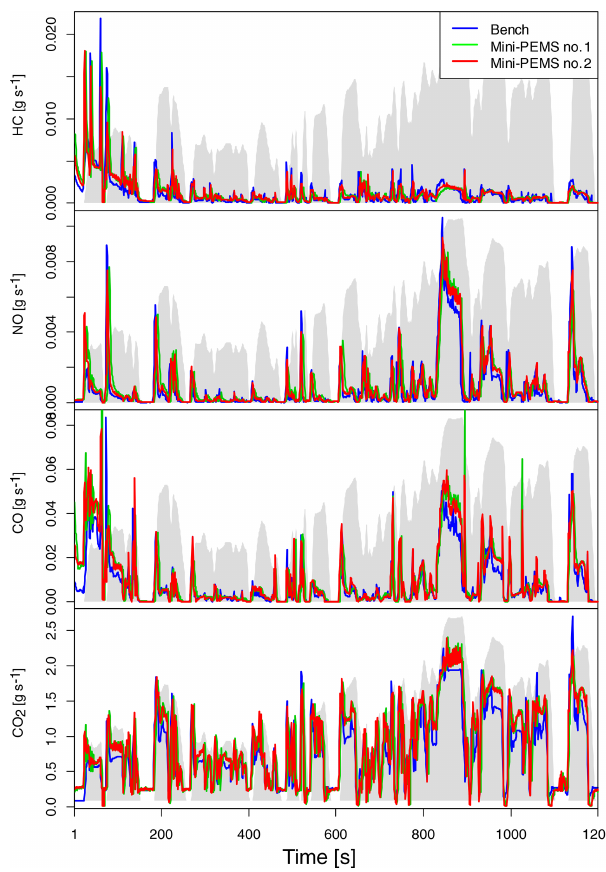
Figure 4. Mass flow rates of HC, NO x , CO, and CO 2 from bench instrumentation and from the two Mini-PEMSs for Vehicle 2 during Test 5